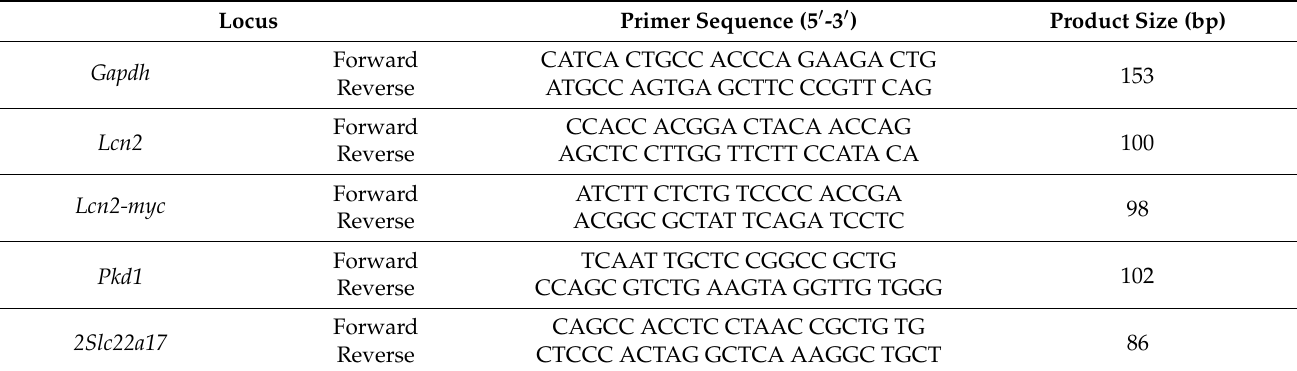
Table 1. Primers used in real-time PCR of the cell